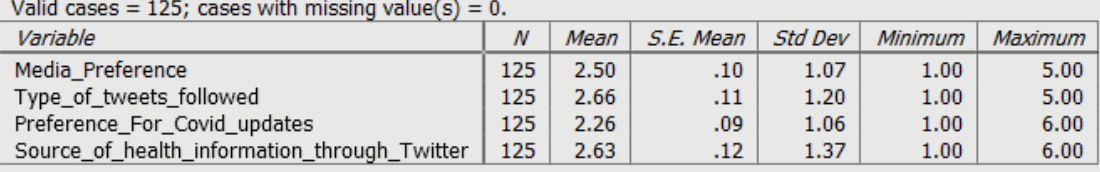
Figure 1: Descriptive Statistics (Source: Online